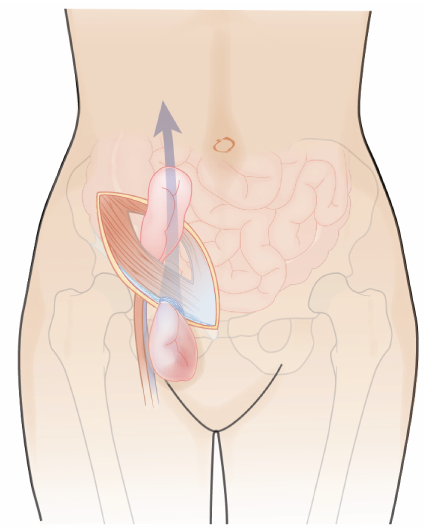
Figure 2: Incarcerated bowel loop is pulled through the femoral ring and eviscerated through the abdominal wall incision.